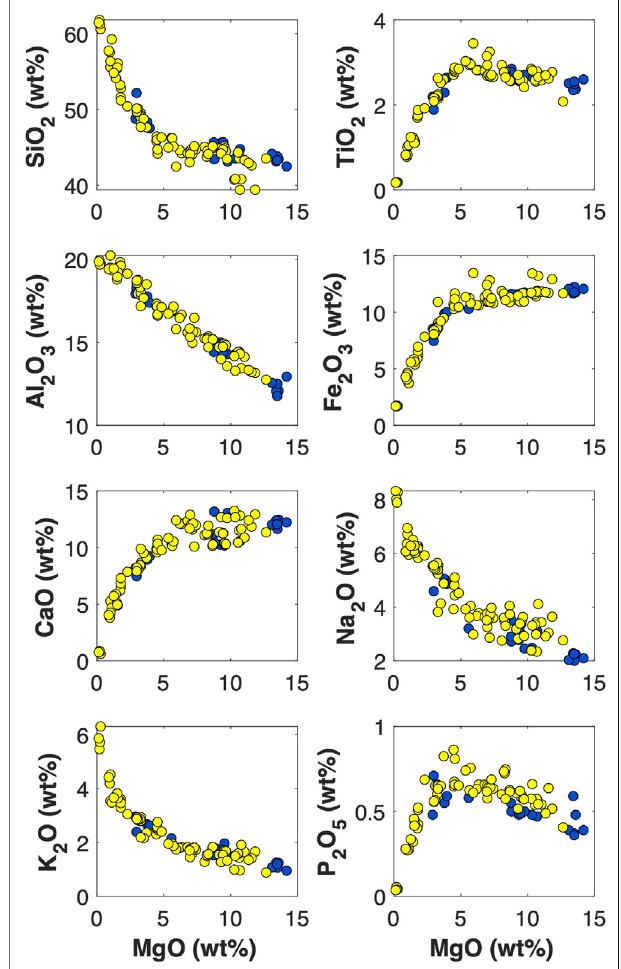
FIGURE 8 | Diagrams of MgO versus concentrations of major element oxide concentrations (Fenner-diagrams). Blue dots are the samples from expedition ARKVII/1 and displayed in yellow are the samples from MSM86.